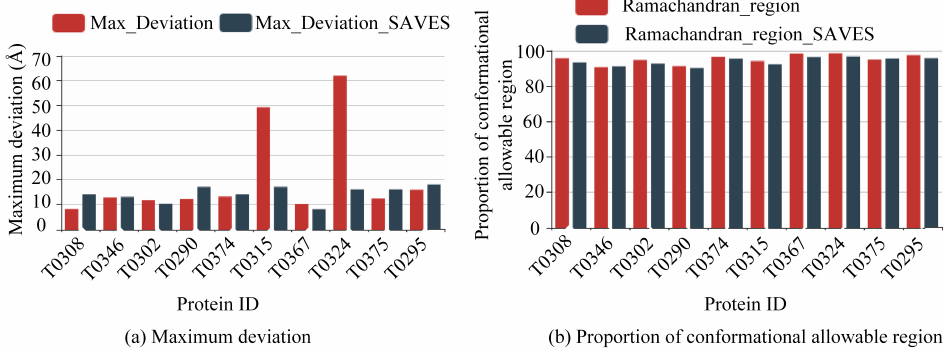
Figure 17. Comparison of multi-level visual analysis method and SAVES evaluation